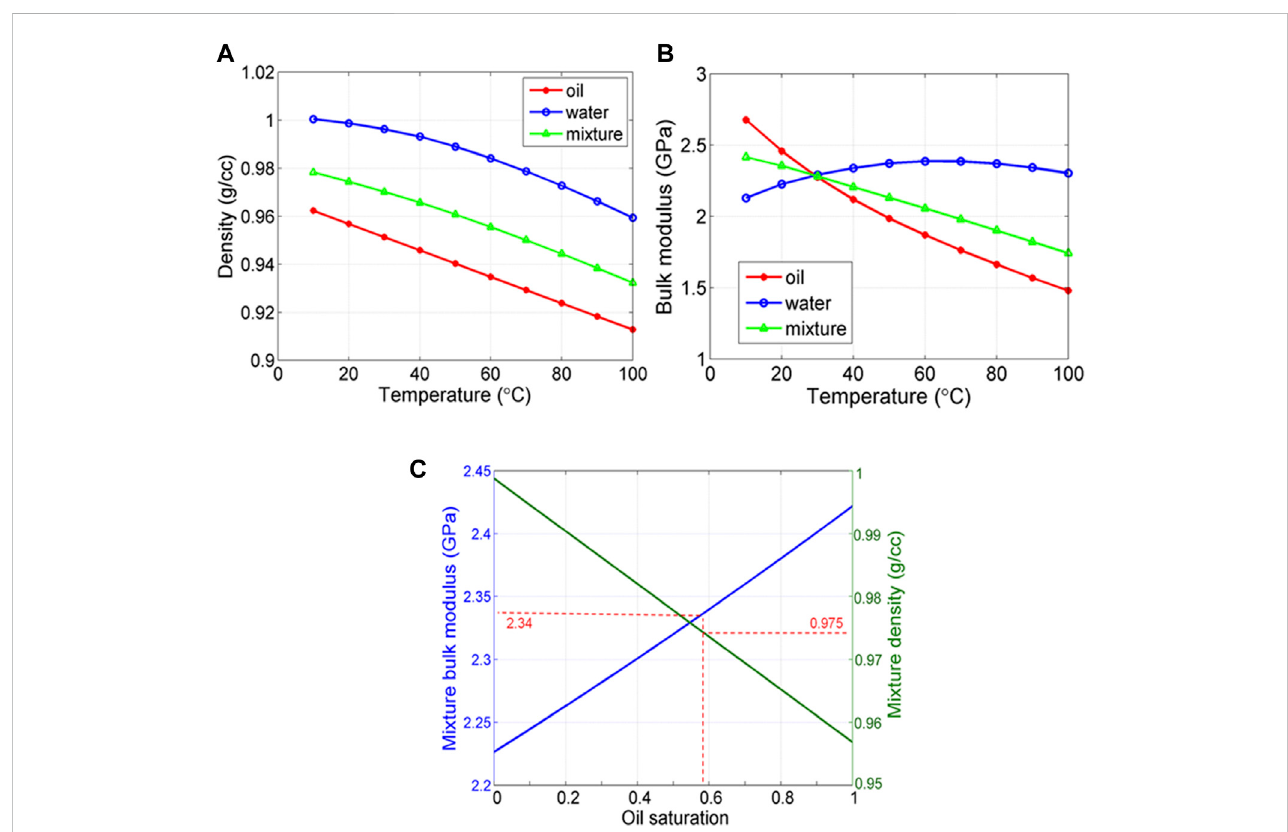
FIGURE 7 Variation of (A) bulk modulus and (B) density of the heavy oil, water, and fl uid mixture with temperature. (C) Variation of bulk modulus and density of the fl uid mixture with oil saturation. The bulk modulus of the fl uid mixture is predicted using Wood ’ s